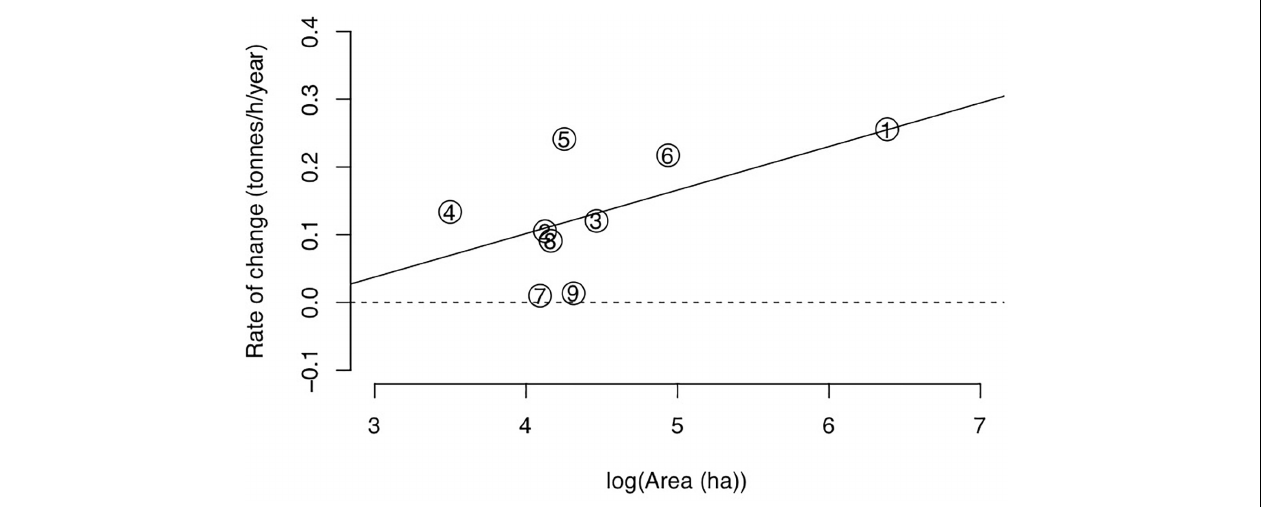
FIGURE 4 | Differential rates of biomass recovery based on total area for each fishing refugia. Each refugia is indicated by a number as follows: (1) San Marcial, (2) San Mateo, (3) Punta Botella, (4) La Morena, (5) La Habana, (6) San Diego, (7) El Pardito, (8) San Francisquito, and (9) Punta Coyote. La Brecha and Estero Tembabiche were excluded from this analysis given that those sites were established primarily to protect juveniles of important commercial in the coastal lagoons, thus no comparable metric of biomass recovery was